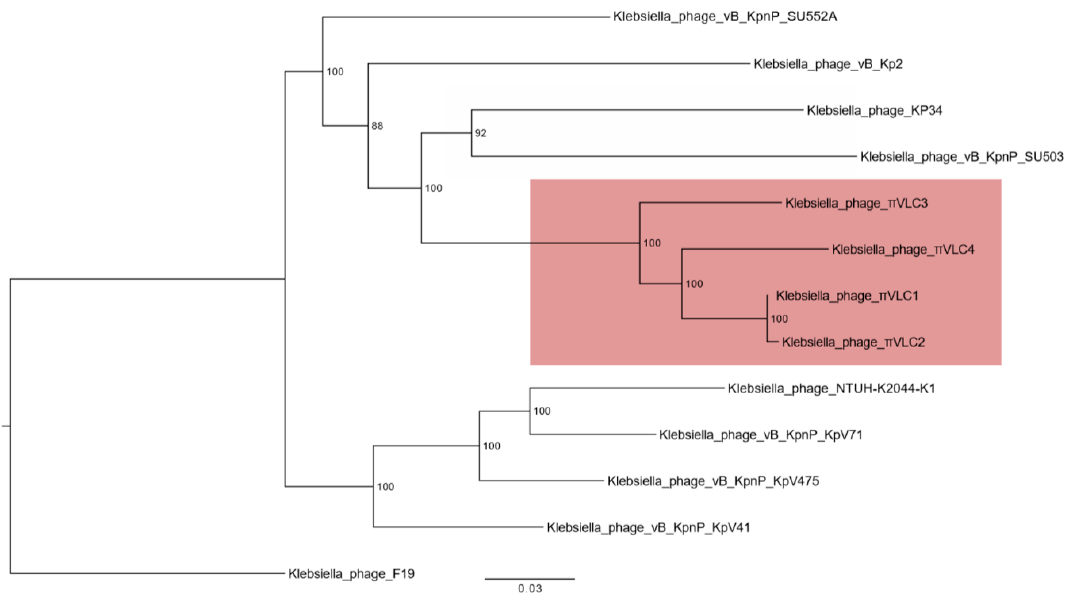
Figure 4. Maximum likelihood phylogenetic tree of whole-genome Drulisvirus sequences. Numbers indicate bootstrap values (1000 pseudo-replicates). The four phages isolated and characterized here are indicated in red.